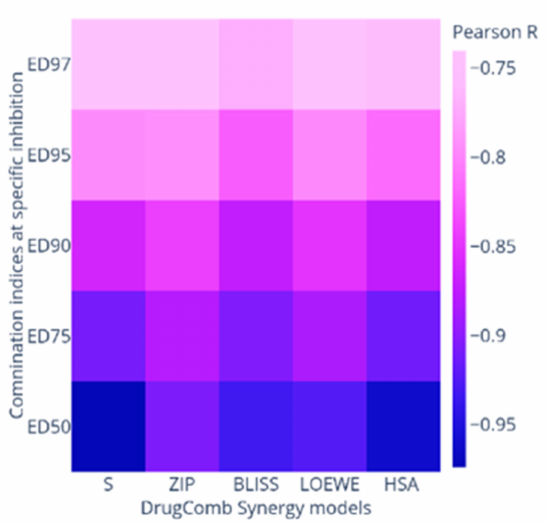
Figure 4. Pearson’s correlation r values among different synergy quantitation metrics.